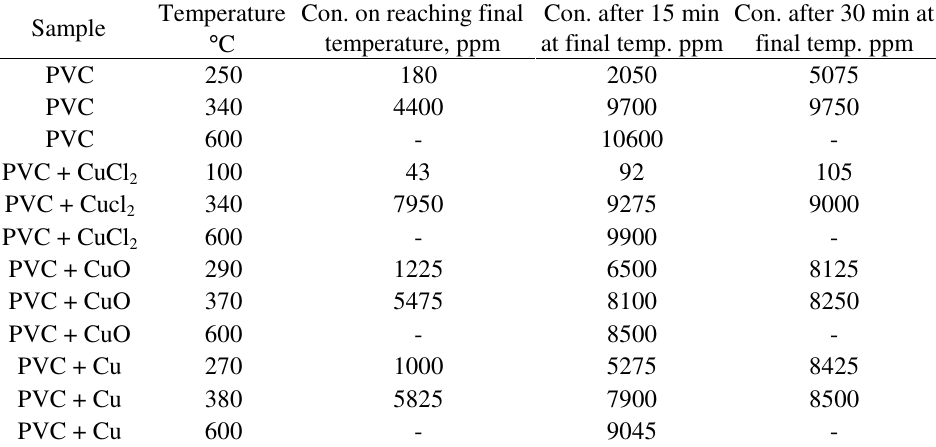
Table 2 . Concentration of Cl plus HCl in gas emission from the combustion of sample in